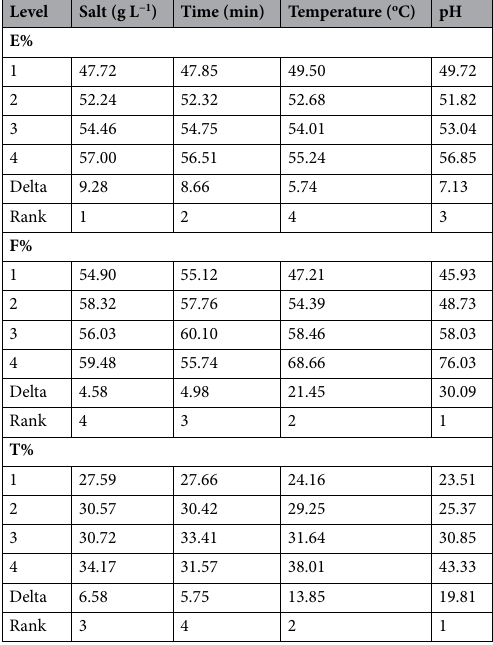
Table 6. Response table for the means in E%, F%, and T% of B194-dyeings.